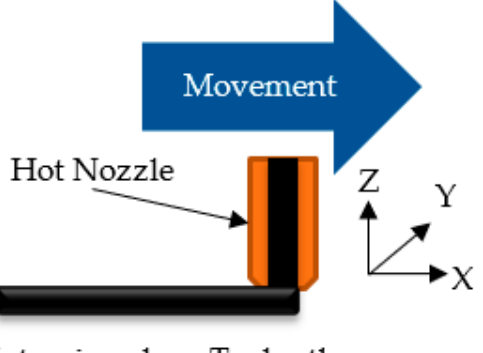
Figure 1. Local coordinate system used to describe the material properties.